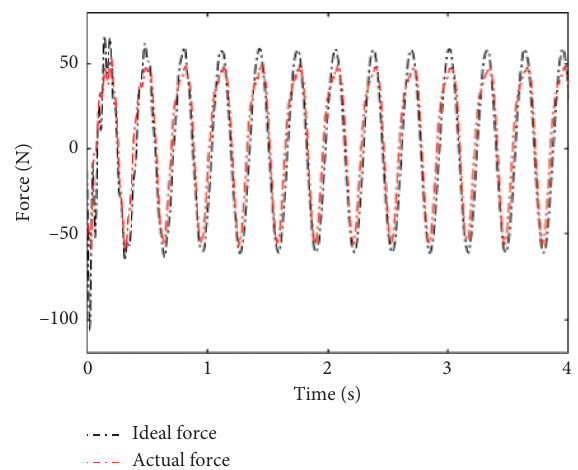
Figure 11: Comparison between actual and ideal damping